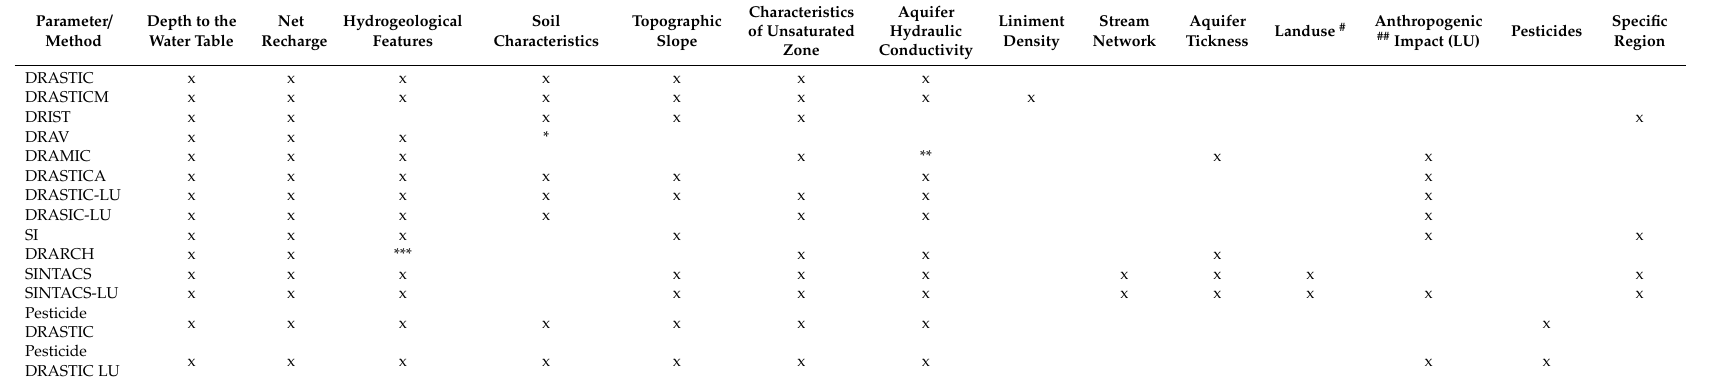
Table 1. Methods and corresponding parameters for groundwater vulnerability